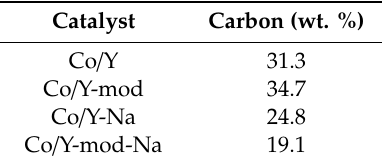
Table 5. Carbon deposition of the catalysts after 34 h of reaction time. (Reaction conditions: H 2 O / EtOH = 13, WHSV 0.95 h − 1 and atmospheric